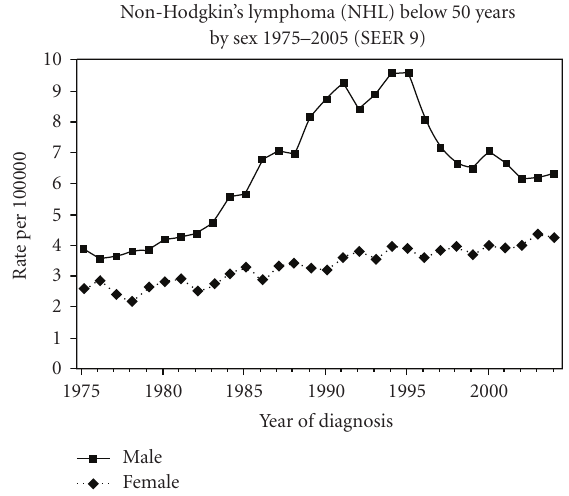
Figure 3: Incidence for all races of human NHL in individuals greater than 50 years of age, adapted from the SEER webpage (http://www.seer.cancer.gov/). Rates are adjusted to the 2000 US Std. Population (19 age groups Census P25-1130).